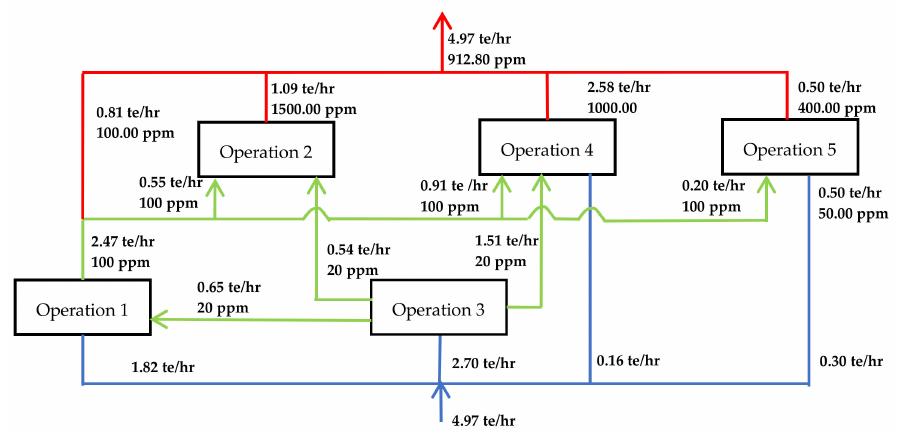
Figure 6. Evolution of the water network evolution. The blue, green, and red lines represent fresh water, water reuse, and effluent streams,